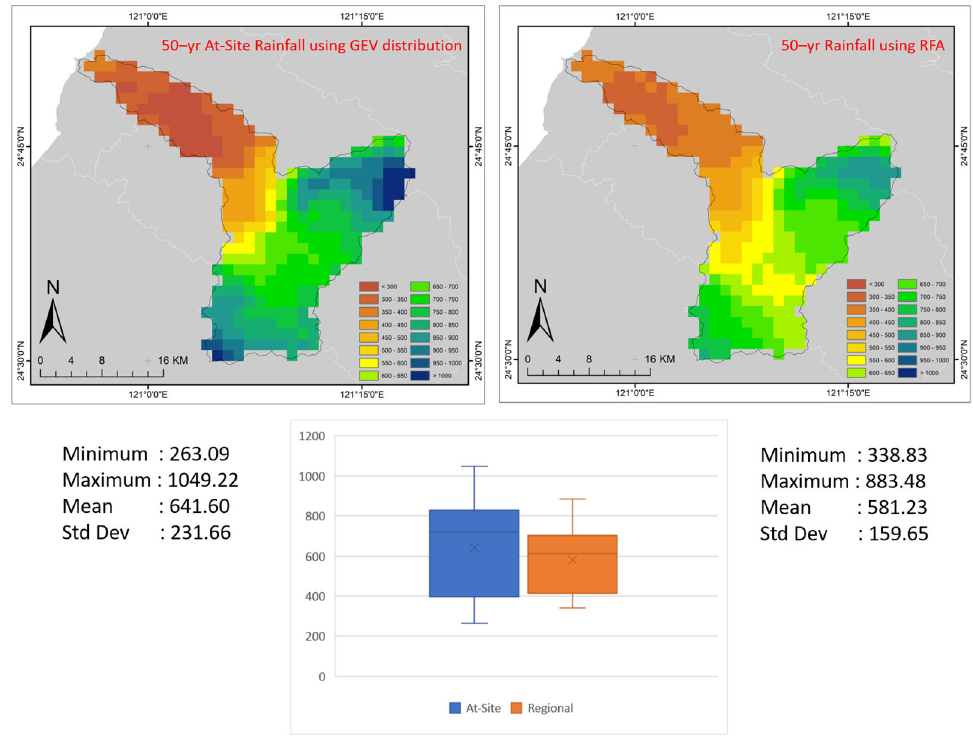
Figure 10. Extreme rainfall for at ‐ site frequency analysis using the GEV distribution and regional frequency analysis at 50 ‐ year return period.